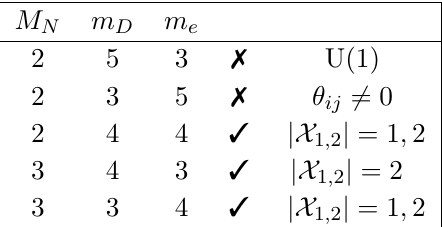
Table 1 . Possible ways to assign the ten parameters of a minimal type-I seesaw model to the mass matrices. The fourth column indicates which parameter assignments can be consistent with a U(1) symmetry and with three non-vanishing mixings. The last column indicates for the non viable cases which condition is violated, and for the remaining cases for which values of the Higgs charges they are